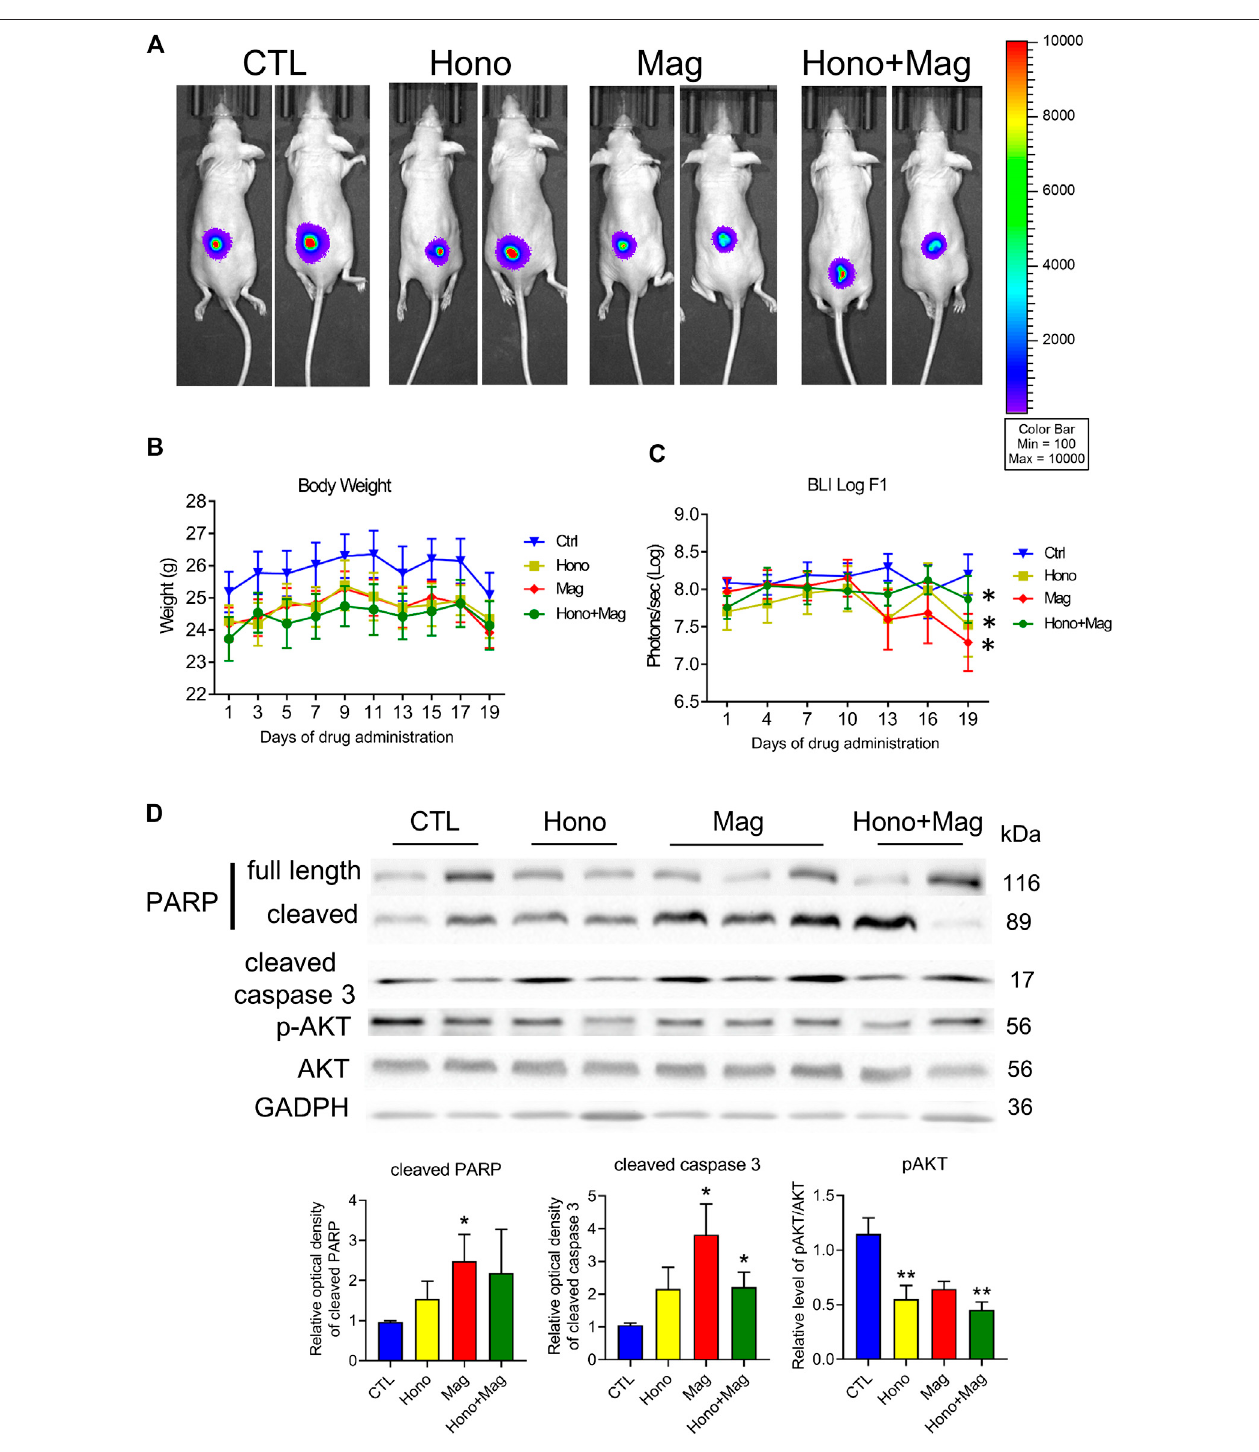
FIGURE 6 | Hono and Mag treatment reduced tumor progression in human T24 bladder cancer cell xenograft model mice. (A) The in vivo bioluminescent imaging datafromdifferentgroupswereanalyzedviatheIVISsystem. (B) Bodyweightwasmeasuredduringdrugtreatment. (C) Thelowerpanelsshowtheresultsofquantitative analysis of tumor progression. *** p < 0.001 compared to the placebo group. (D) Levels of the PARP and cleaved caspase 3 proteins were determined by Western blotting. The lower panels show the results of quantitative protein analyses. * p < 0.05; ** p < 0.01 compared to the control group.